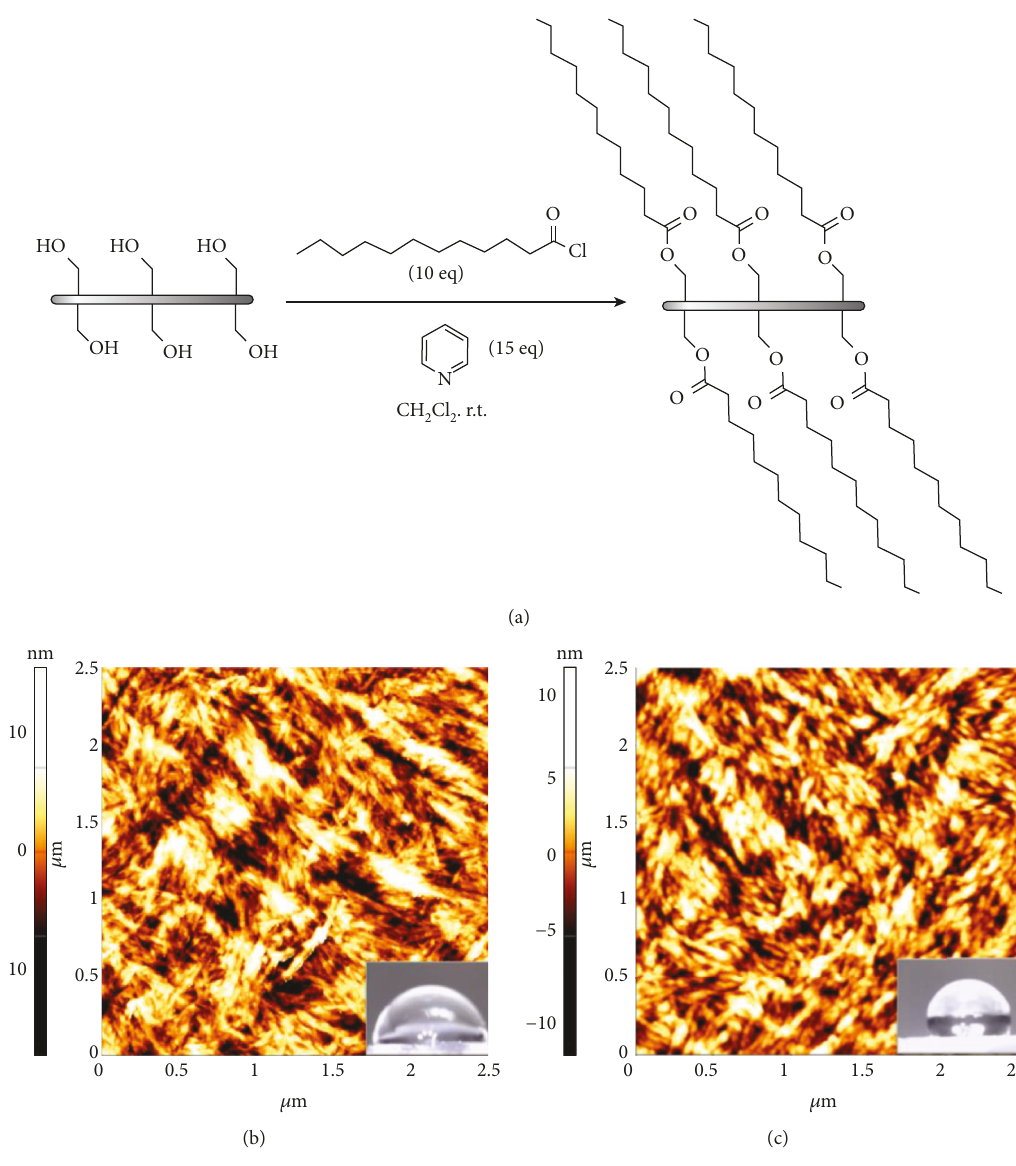
Figure 9: (a) Topochemical hydrophobization of CNP produced by dipping in lauroyl chloride solutions, with pyridine as catalyst. The reaction produces nanopaper with a very low DS ( < 0.1); (b) AFM 2 5 × 2 5 μ m 2 topography of the surface of pristine nanopaper. Inset: water contact angle on pristine nanopaper; (c) AFM 2 5 × 2 5 μ m 2 topography of the surface of hydrophobized nanopaper. Inset: water -CNP. Reproduced from reference [45] with permission from the Royal Society of contact angle on hydrophobized nanopaper, C 12